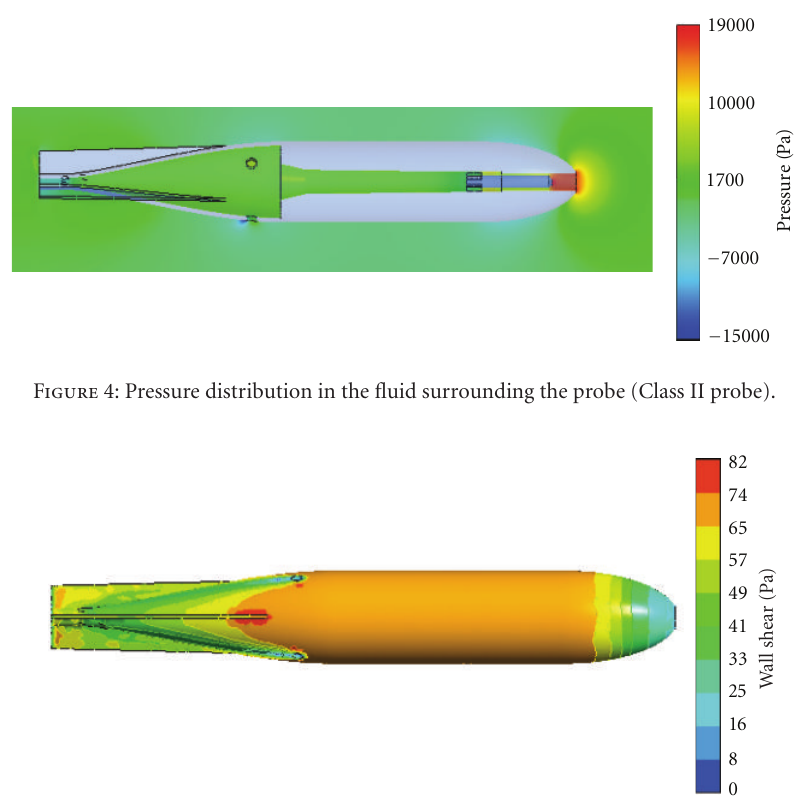
Figure 5: Distribution of surface shear stress (Class II probe).